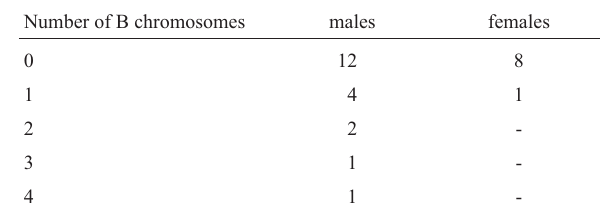
Table 1 - B chromosome distribution in Cyphocharax modestus from the Paranapanema